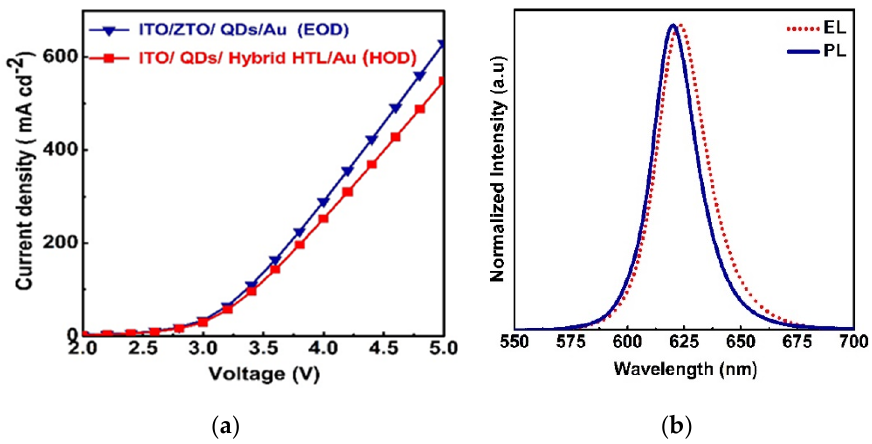
Figure 6. ( a ) HODs and EODs comparisons; ( b ) comparison of the EL spectrum of an as-designed device with the PL spectrum of the QDs in film state. Table 1. Comparisons of the characteristics of the reference device and as-designed device. Device No.